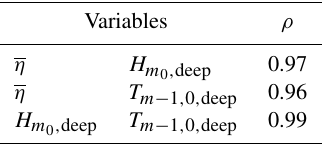
Table 2. Pearson correlation coefficients ( ρ ) for Gaussian